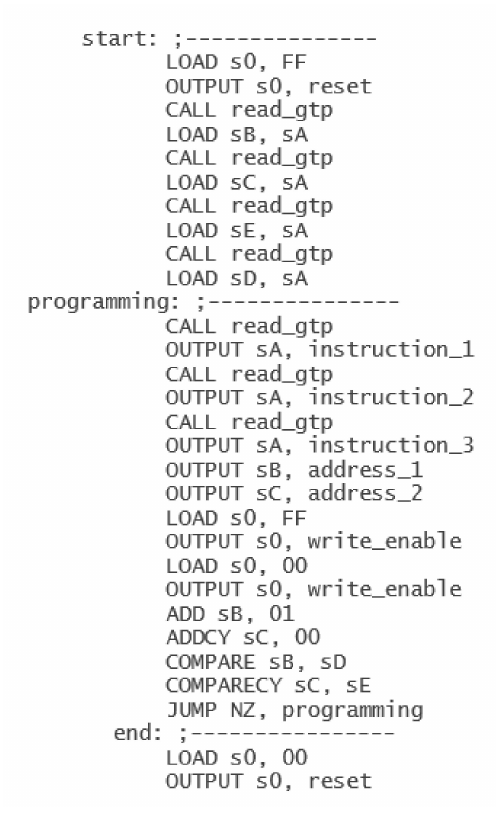
Figure 4. PicoBlaze reprogramming